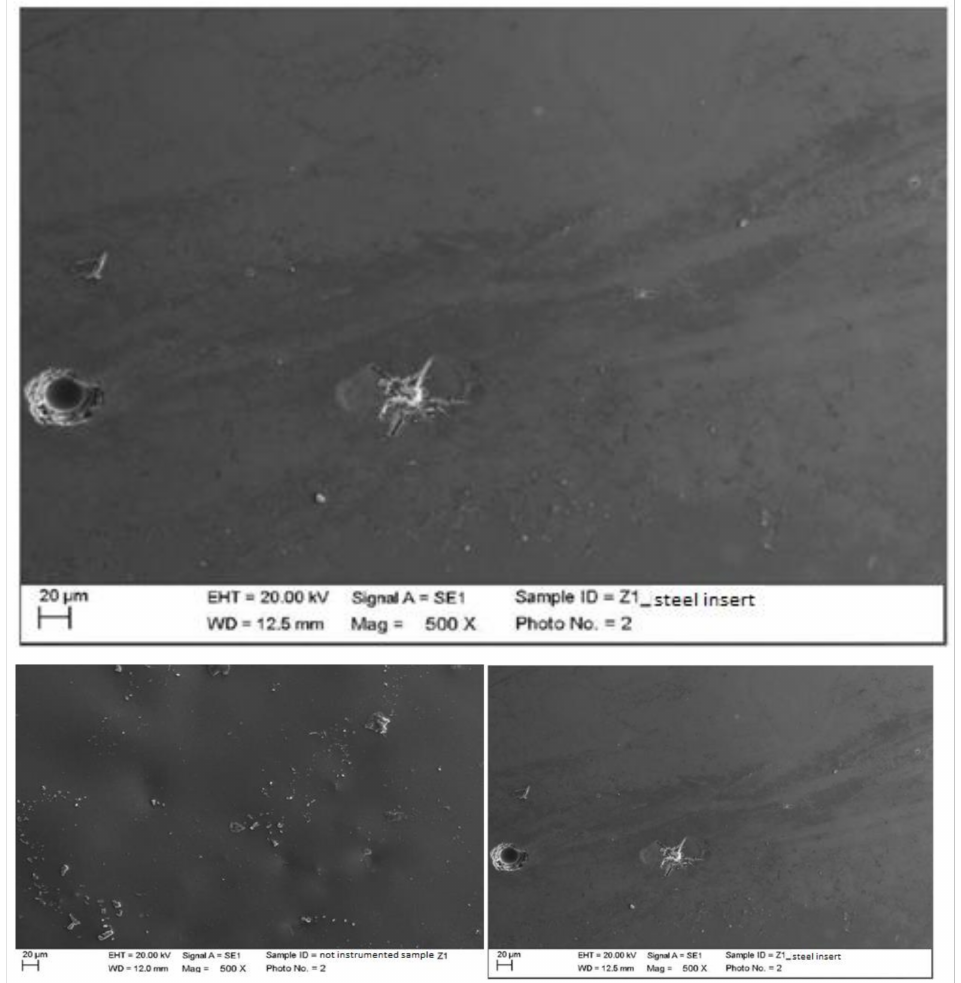
Figure 18. Instrumented zirconium sample Z1 with steel insert (500 × ). Comparison before/after